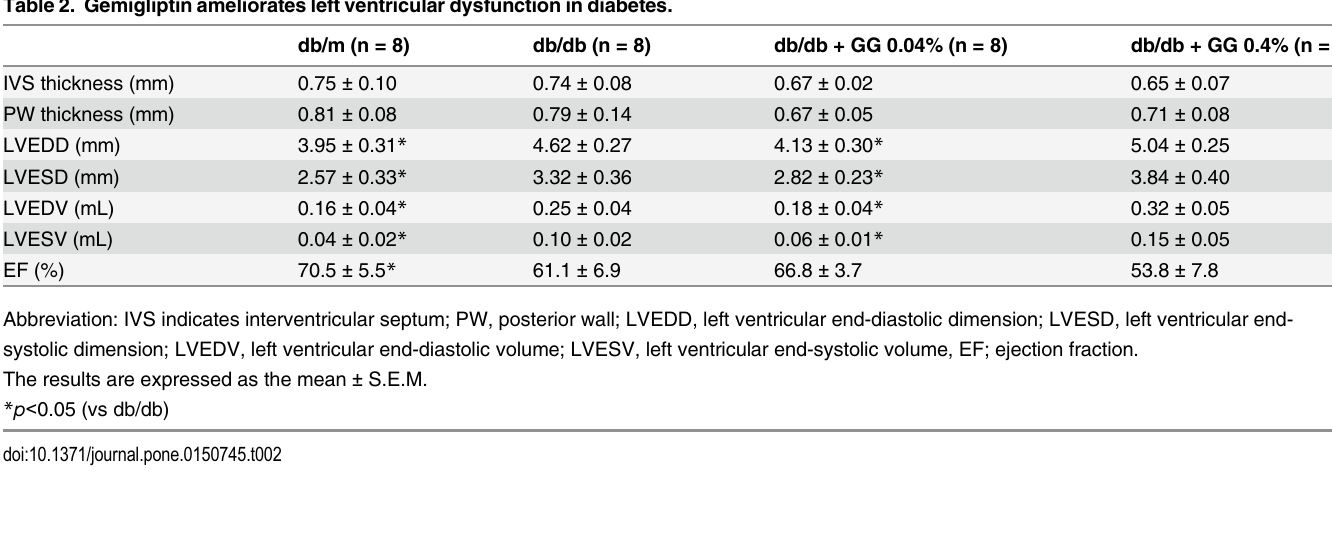
Table 2. Gemigliptin ameliorates left ventricular dysfunction in diabetes.